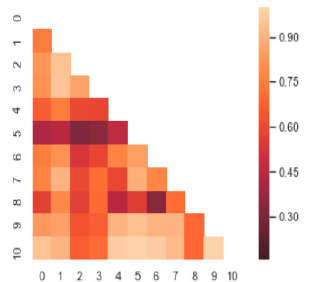
Figure 4. Example of correlation matrix.